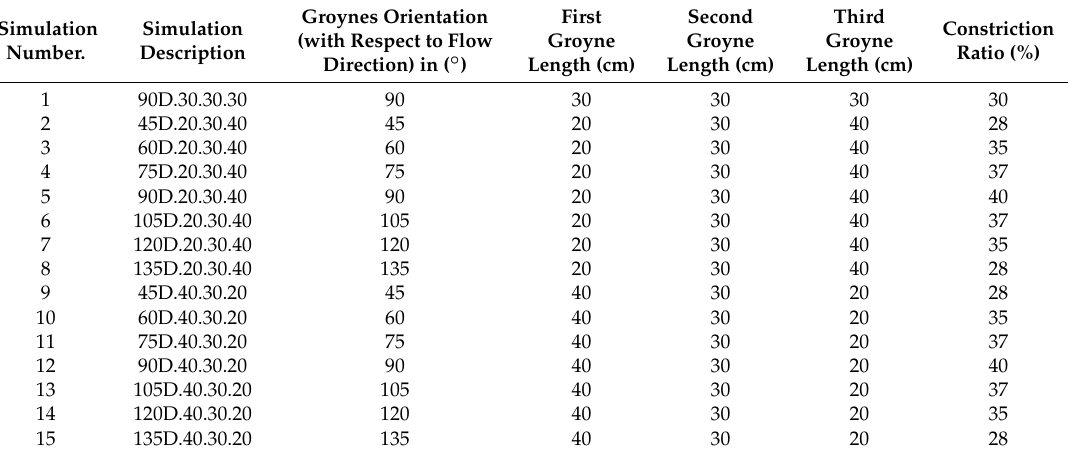
Table 5. Characteristics of the